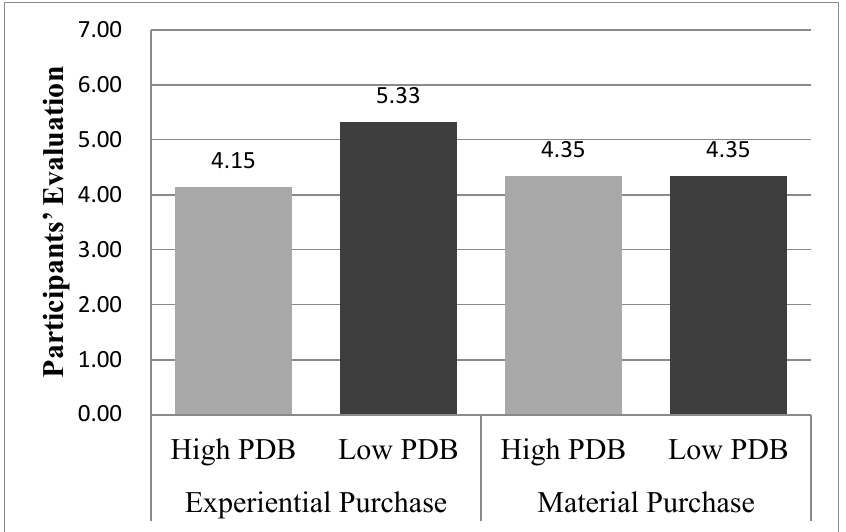
Figure 2. Result of study 1.